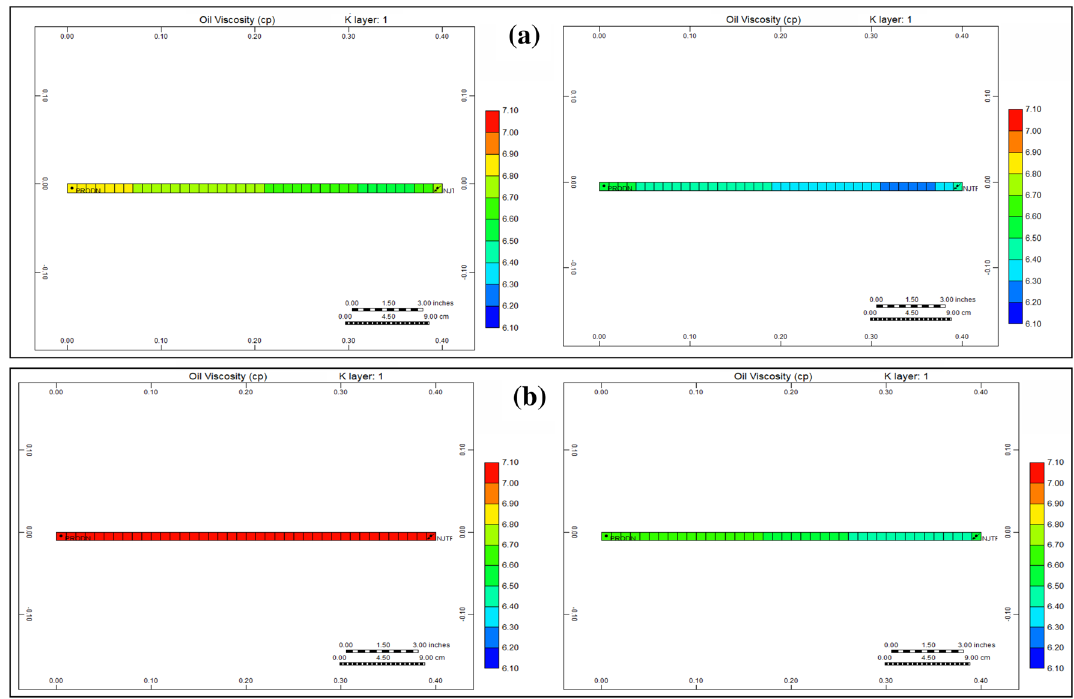
Fig. 6 Oil viscosity variation per component content: a light oil fraction and b CO